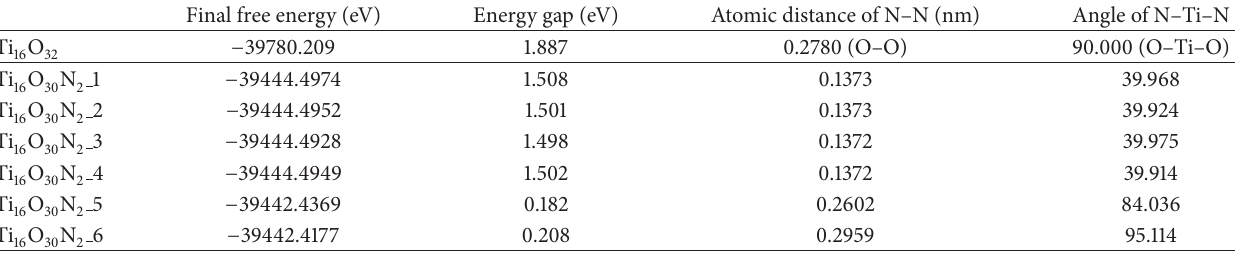
Table 3: The total energy and band gaps of rutile and six kinds of N-doped rutile TiO and Angle of N–Ti–N.